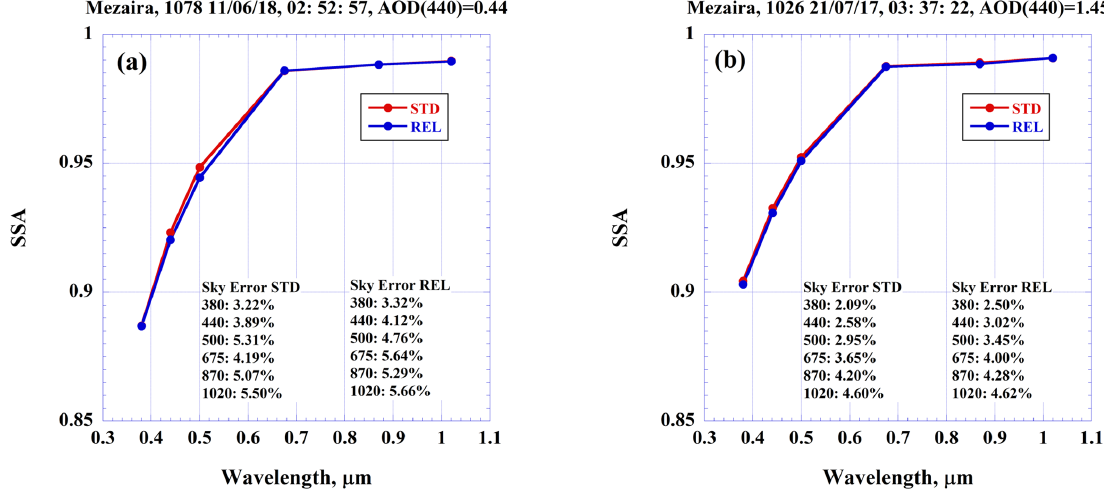
Figure 5. SSA retrieved using V3 assumptions on the IPRI smoothness constants (STD) and that of relaxed constraints (REL) at the Mezaira AERONET site: (a) AOD(440) = 0.44, AE = 0.24 and (b) AOD(440) = 1.45, AE = 0.2.